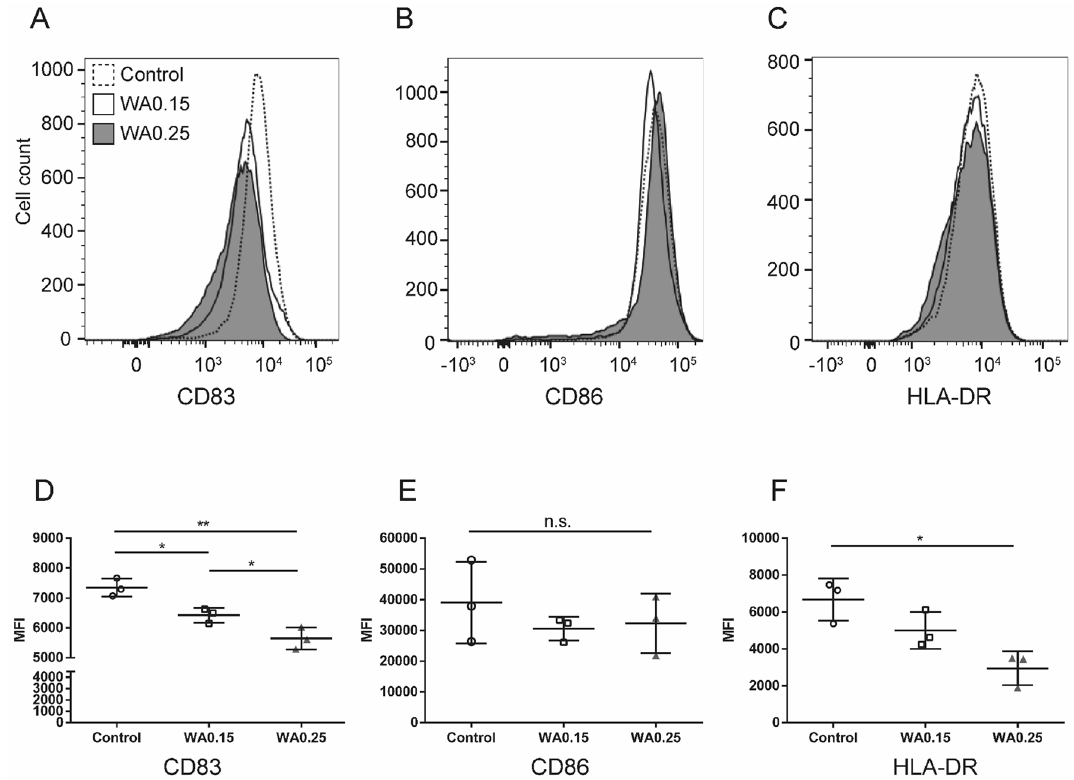
Figure 5. Inhibitory effect of WA treatment against human DC maturation. Human PBMCs isolated from healthy donors were cultured in a medium containing 0.15 or 0.25 μg/mL WA for the generation of mature DCs. Expression of ( A ) CD83, ( B ) CD86, and ( C ) HLA-DR was detected by flow cytometry after 48 h of culture. The dotted and clear histograms represent control cells and WA 0.15 μg/mL treated cells, respectively. The gray area represents WA 0.25 μg/mL–treated cells. ( D–F ) Median fluorescent intensity (MFI) of ( D ) CD83, ( E ) CD86, and ( F ) HLA-DR. Control (circle), WA0.15 (square), WA0.25 (gray triangle). * P < 0.05, ** P < 0.01, n.s.; not significant. n = 3 independent